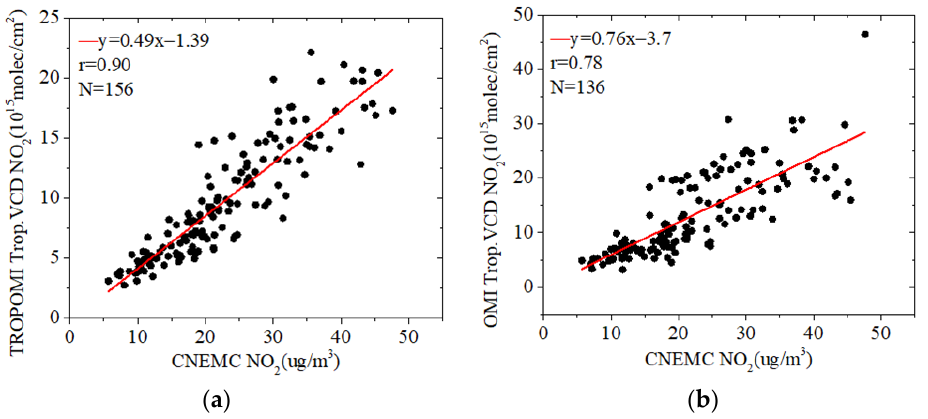
Figure 8. Scatterplot of the monthly averaged NO 2 concentrations from CNEMC, TROPOMI and OMI NO 2 , respectively. ( a ) CNEMC and TROPOMI , ( b ) CNEMC and